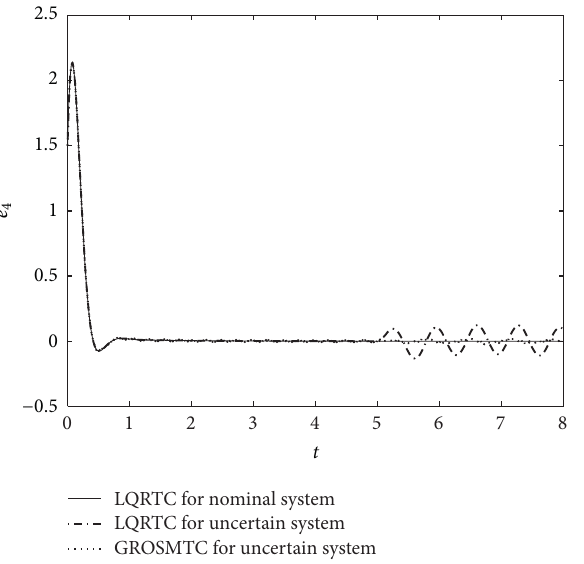
Figure 7: The tracking response curve of the velocity ̇𝑞 1 for link